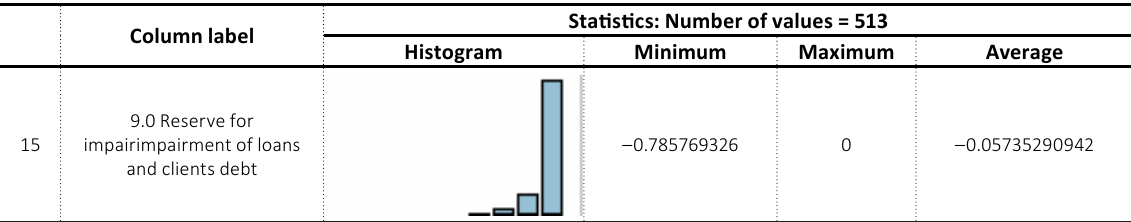
Source: Developed by the authors.